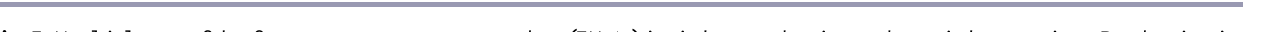
Fig. 5 . Multiple use of the forest management approaches (FMA) in timber production and nontimber services. Production is expressed as land expectation value (LEV) at an interest rate of 1% (at left) and 3% (at right) in monetary terms, woody debris measured in physical terms is provided as a surrogate for biodiversity. Further, the amount of the coarse woody debris is provided in brackets beside the labeling of the points. As a crude estimate, specialized management at the landscape level is superior at an interest rate of 1% (FMA 4 contains only fine woody debris). In contrast, at a 3% interest rate, multiple-use approaches are beyond the dotted regulatory line between specialized